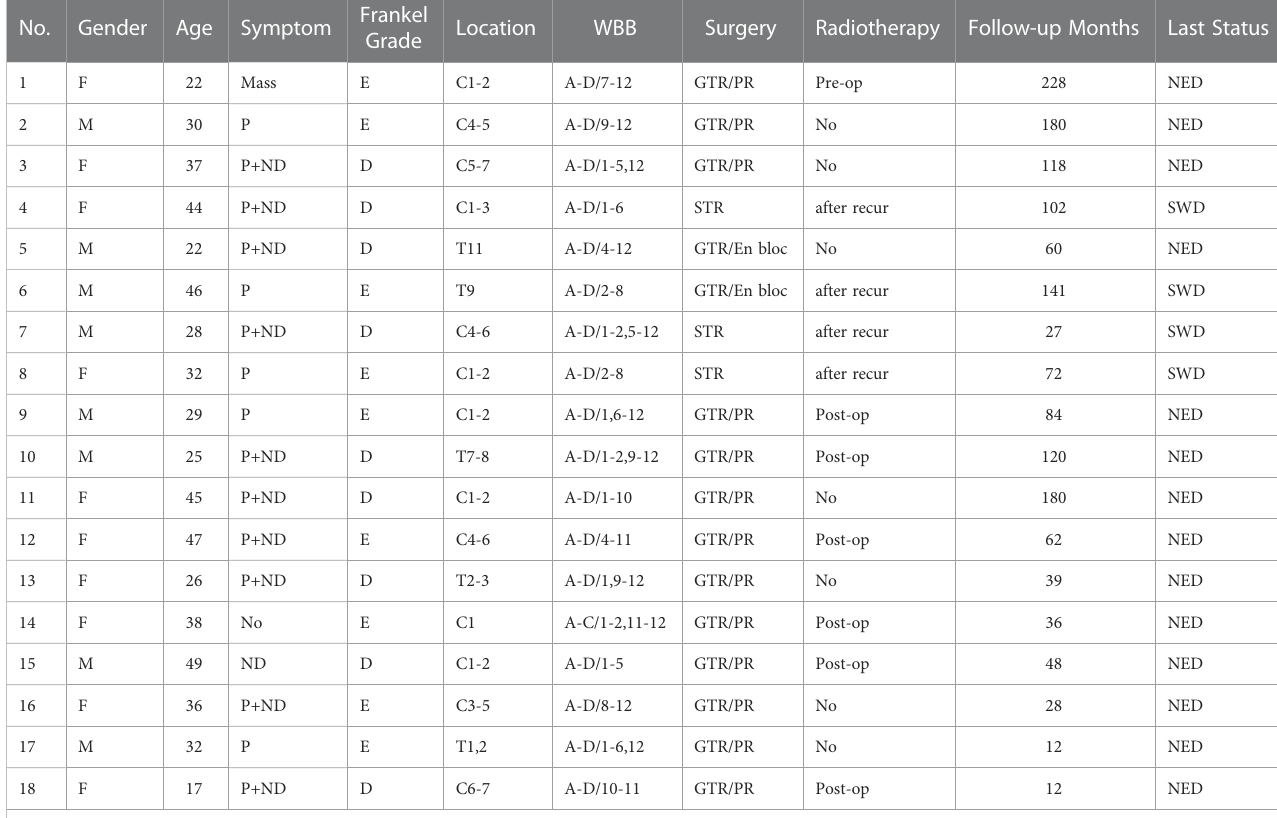
TABLE 1 Treatment and Outcomes of Spinal tenosynovial giant cell tumor in Our Group.